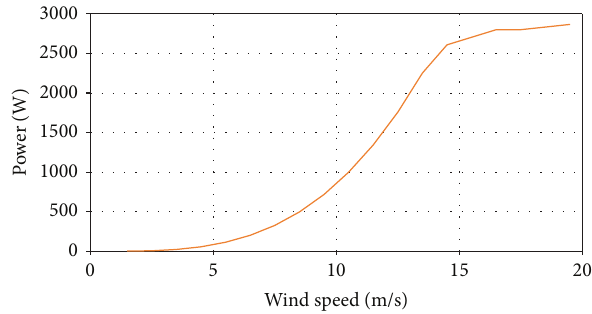
Figure 6: Power diagram variation at different wind speeds for analyzed Romanian regions.